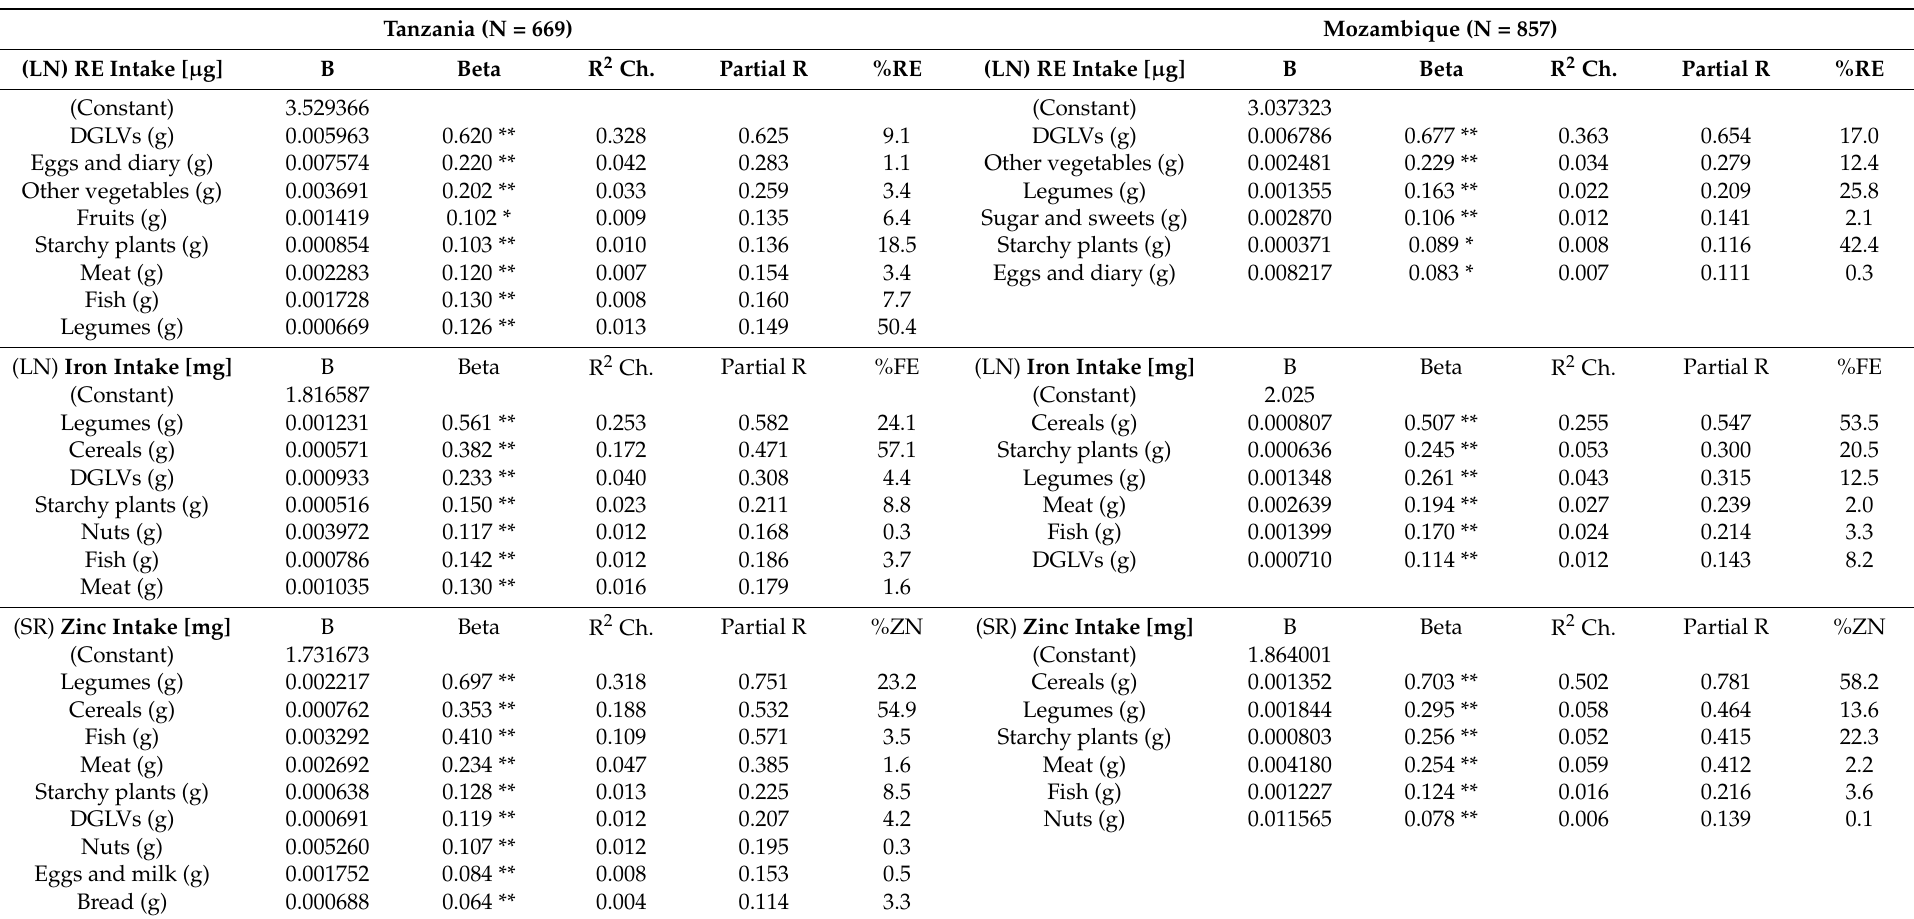
Table 4. Multiple linear regression assessing food groups consumption (in grams) as predictors of vitamin A (RE), iron and zinc